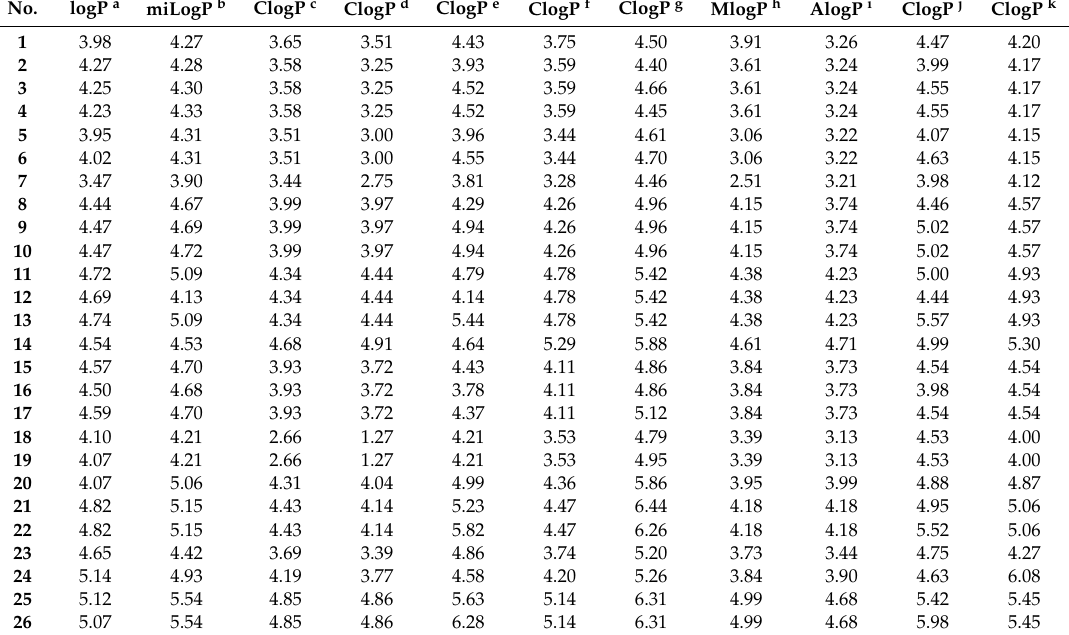
Table 3. Theoretically estimated partition coe ffi cient calculated by set of alternative methods for N -(methoxy / methyl-phenyl)-1-hydroxynaphthalene-2-carboxamides 1 – 26 . No.